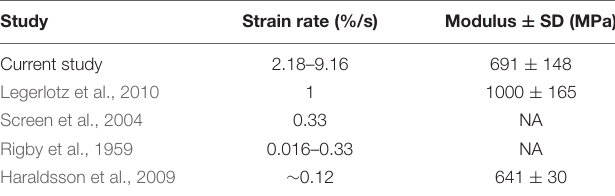
of Elastic Modulus are comparable to previously reported